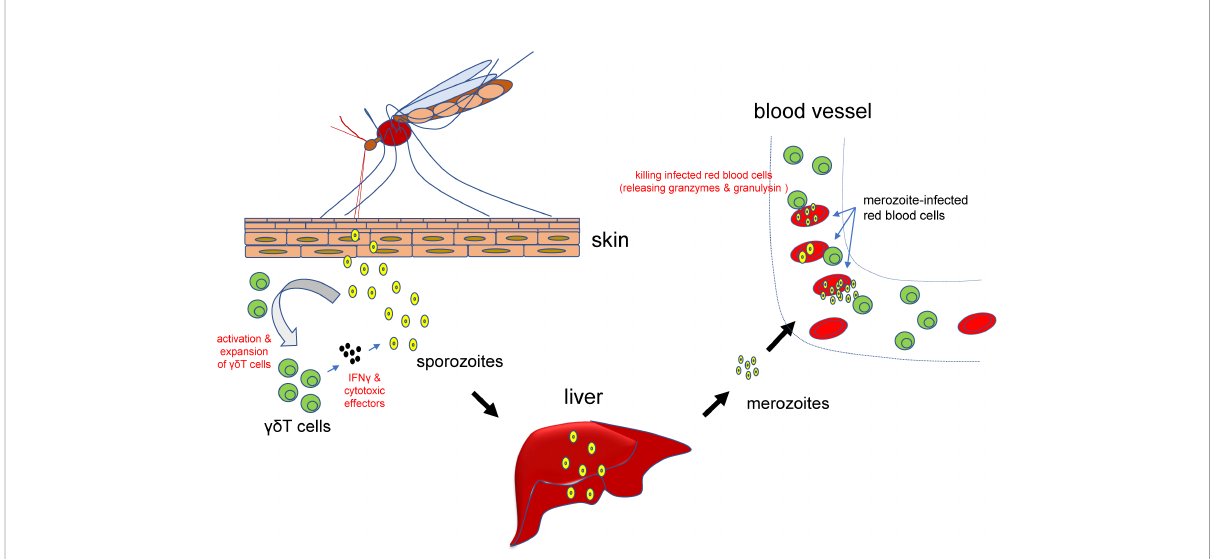
FIGURE 2 Roles for gd T cells in malaria parasites infection. At the early stage of infection, gd T cells can be activated and expanded and subsequently secret IFN- g and other cytotoxic effectors to prevent or attenuate the infection. After the parasites have infected blood cells, activated gd T cells can also bind to the infected cells, release granzymes and granulysin, and kill the invaded plasmodium parasites and infected red blood